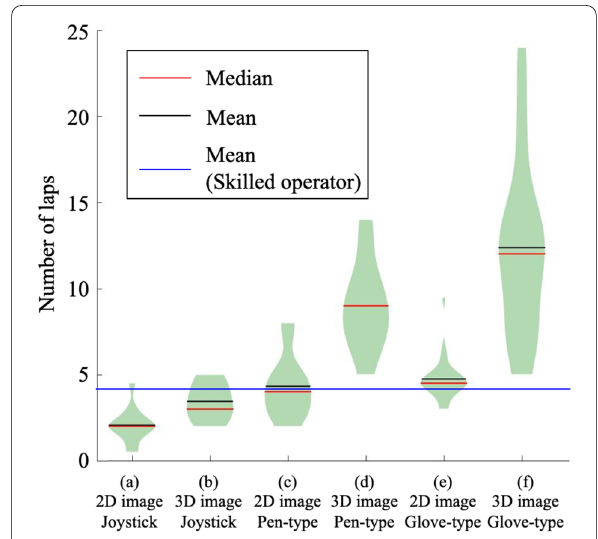
Fig. 15 Violin plots of the number of laps